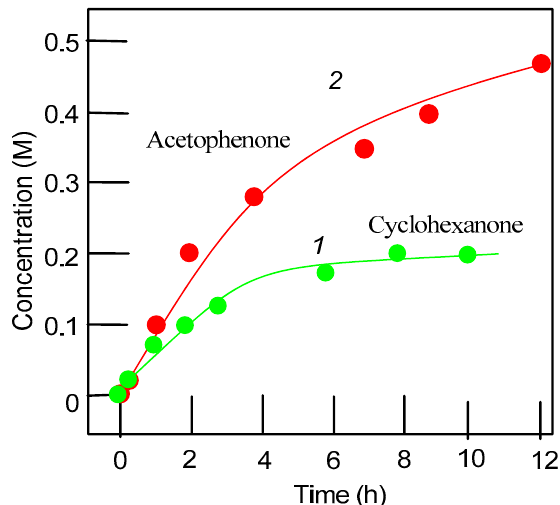
Figure 10. Accumulation of cyclohexanone (curve 1 ), and acetophenone (curve 2 ) in the oxidation of cyclohexanol (0.5 M) or 1-phenylethanol (0.5 M), respectively, with tert -butyl hydroperoxide (1.5 M) catalyzed by complex 1 (5 × 10 − 4 M) at 50 °C in acetonitrile. In order to quench the oxidation process concentrations of products were measured by GC only after the reduction of the reaction sample with solid PPh 3 .